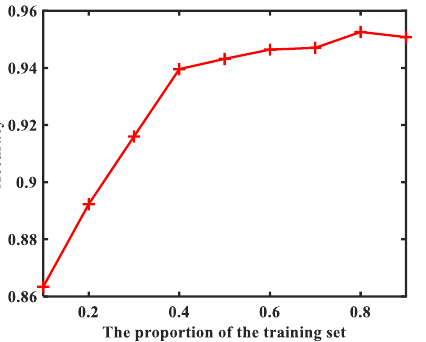
Figure 9. The performance with different proportions of the training set.